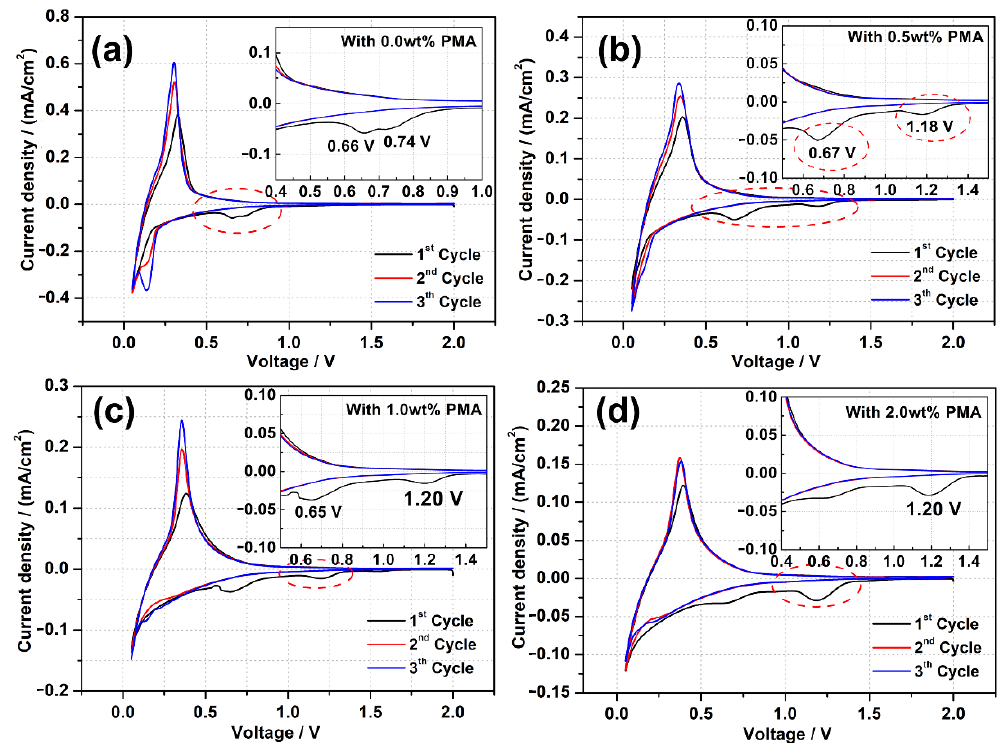
Figure 1. CV curves and their enlarged regions of the MCMB electrodes recorded in the base elec- trolyte containing ( a ) 0.0 wt%, ( b ) 0.5 wt%, ( c ) 1.0 wt% and ( d ) 2.0 wt% of PMA additive at a scan rate of 0.1 mV/s.